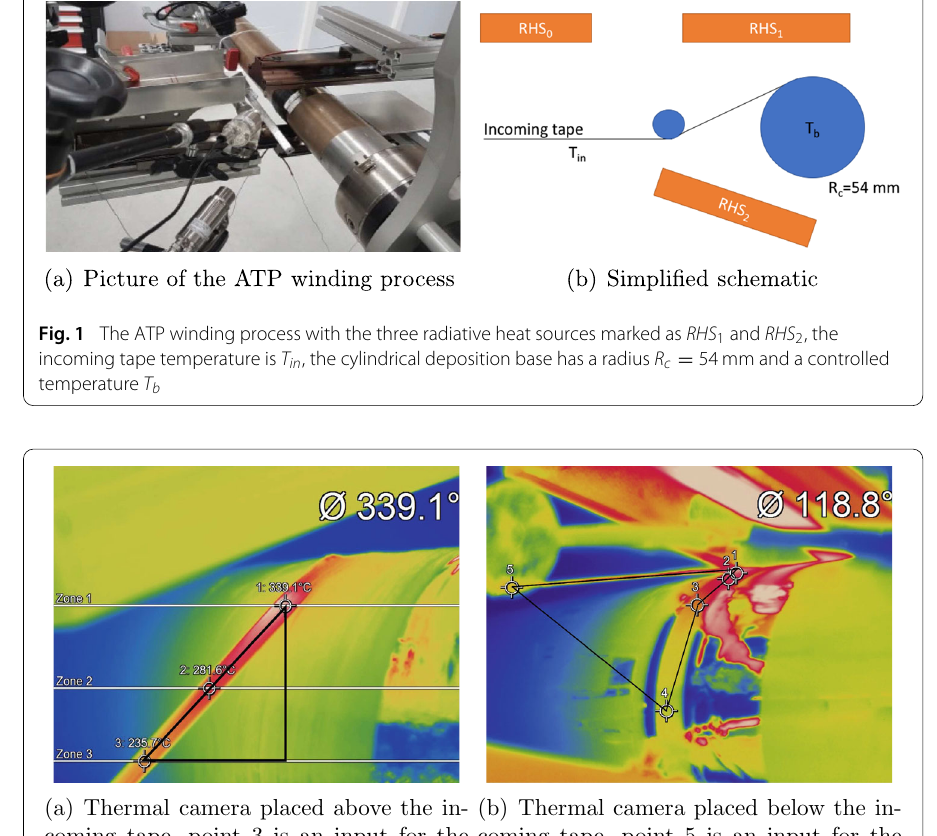
Fig. 2 The thermal camera with the control points 1 and 2 from a and 1 to 4 from